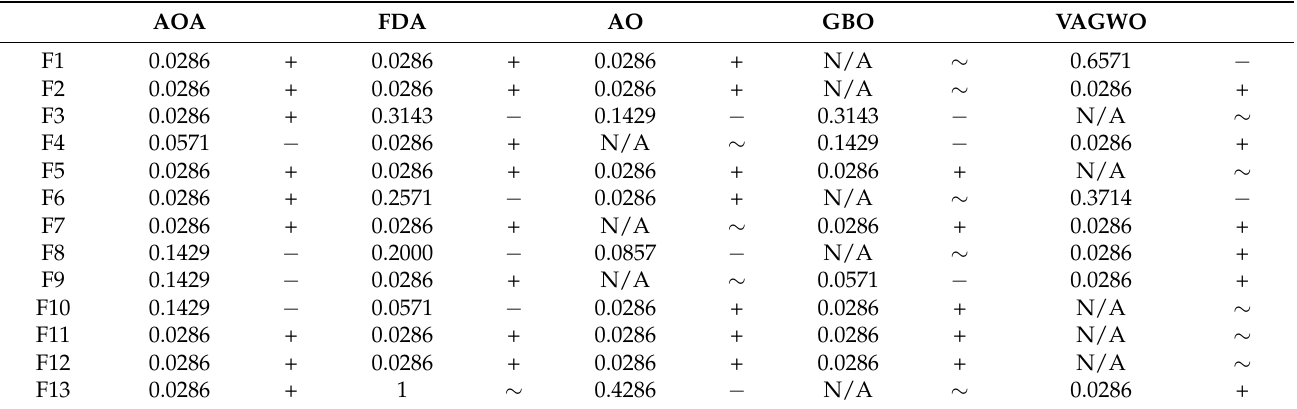
Table 11. p -values and signs of Wilcoxon test for VAGWO against the newly proposed algorithms on the standard functions.